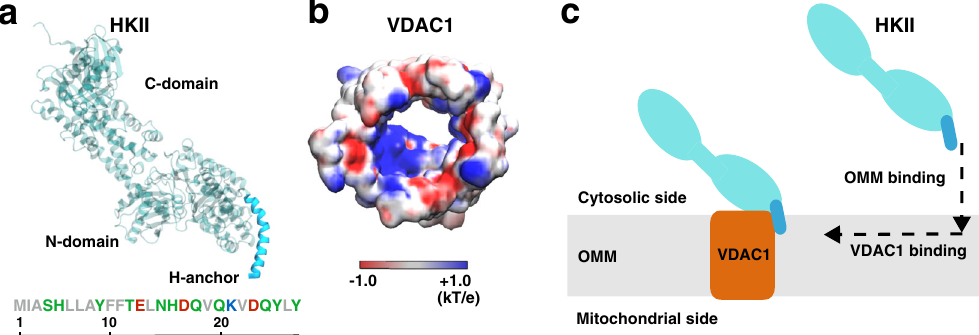
Fig. 1 HKII and VDAC1 structures and the design of our modeling approach. a The structure of HKII contains N- and C-domains (teal), and an N-terminal helix named here as H-anchor (cyan). The amino acid sequence of H-anchor is shown below, colored by their residue types: gray representing hydrophobic, green polar, red acidic, and blue basic amino acids. b The top-down view of VDAC1 colored by its electrostatic potential, generated using the Poisson – Boltzmann (PB) equation solver in CHARMM-GUI 73,86,93 . c Schematic representation describing our modeling approach in which HKII binds the outer mitochondrial membrane (OMM) fi rst, and then membrane-bound HKII forms a complex with